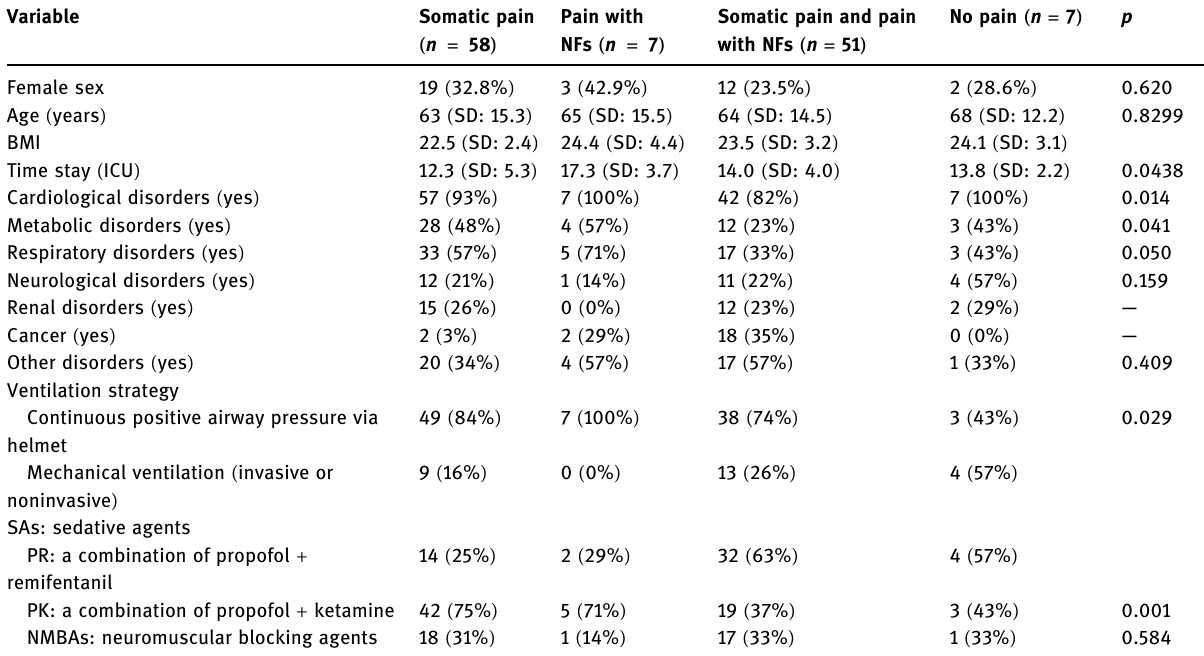
Table 3: Frequency distribution of patients ’ characteristics during ICU staying by perceived pain